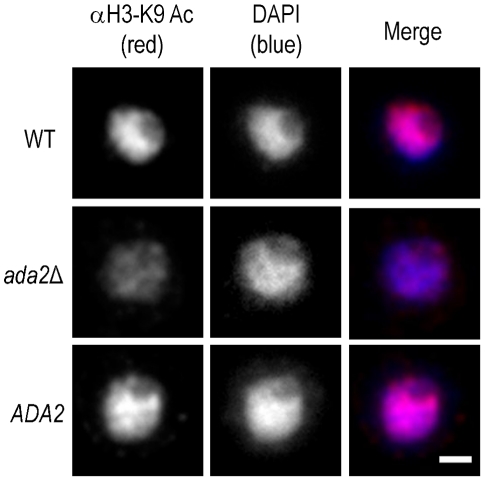
Histone acetylation is markedly reduced in the absence of Ada2.Shown are immunofluorescence micrographs of wild type (WT), ada2Δ, and complemented ada2Δ (ADA2) cells grown in capsule inducing conditions for 90 min and then probed with antibody to H3K9 (αH3-K9). All images were acquired at the same settings and are shown at the same magnification; scale bar, 1 µm.